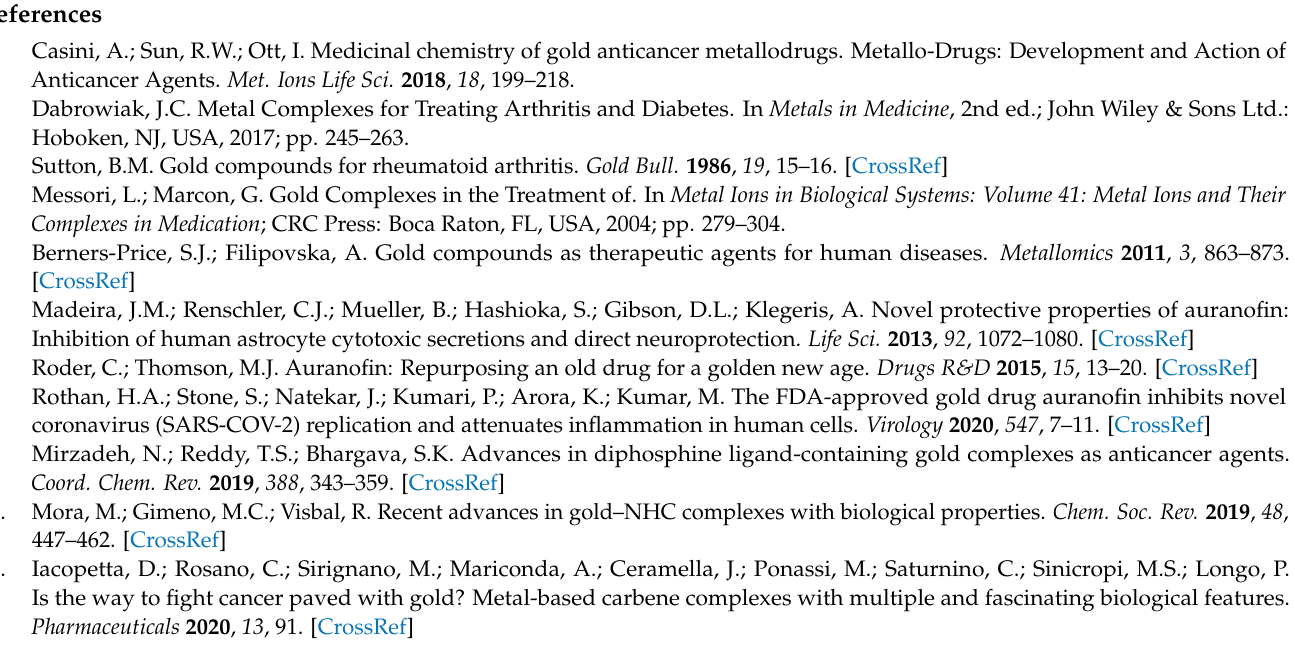
7/14/1/10/s1, Figure S1: ESI MS spectrum for 1 ; Figure S2: ESI MS spectrum for 2 ; Figure S3: UV-Vis spectrum for 1 ; Figure S4: UV-Vis spectrum for 2 ; Figure S5: IR spectrum for 1 ; Figure S6: IR spectrum for 2 ; Figure S7: 1 H NMR spectrum for 1 (registered in CDCl 3 ). Inset: details zoom to 7–9 ppm; Figure S8: 1 H NMR spectrum for 2 (registered in CDCl 3 ); Figure S9: 1 H NMR spectrum for Hpben. Inset: details zoom to 7–9 ppm; Figure S10: 13 C NMR spectrum for Hpben; Figure S11: Heteronuclear Multiple Quantum Coherence (HMQC) correlation for Hpben; Figure S12: Heteronuclear Multiple Bond Correlation (HMBC) for Hpben; Figure S13: 13 C NMR spectrum for 1 (registered in CDCl 3 ); Figure S14: 31 P NMR spectrum for 1 (registered in CDCl 3 ); Figure S15: 13 C NMR spectrum for 2 (registered in CDCl 3 ); Figure S16: 31 P NMR spectrum for 2 (registered in CDCl 3 ); Figure S17: MERCURY view for 1 ; Figure S18: MERCURY view for 2 ; Figure S19: Cytotoxicity curves for 1 and 2 ; Checkcif files for the crystal structures of 1 and 2